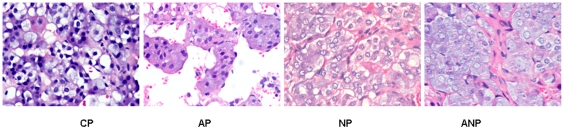
Histopathology examination of adrenal medulla in maternal
rats.The shape of adrenal medullar cell was regular, and damaged structure was
not observed in CP rats. Adrenal medulla vacuolar degeneration and lipid
increases were observed in AP rats, which was aggravated in NP rats and
alleviated in ANP rats. (The magnification of the image is 400
×).